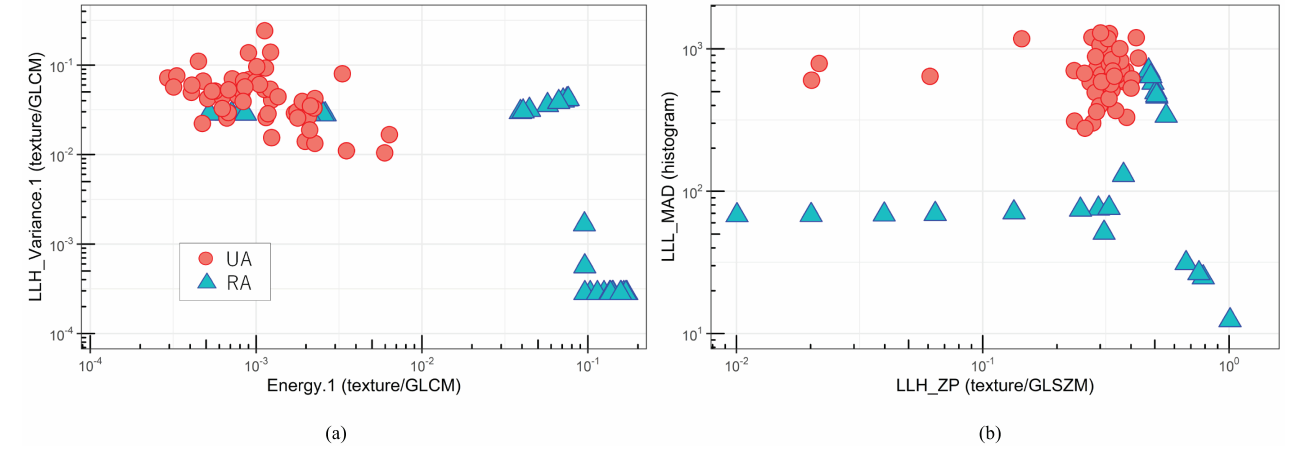
Figure 4. Scattered plots of image features selected by LASSO for RA and UA training cases: ( a ) 1st and 2nd features; ( b ) 3rd and 4th features.